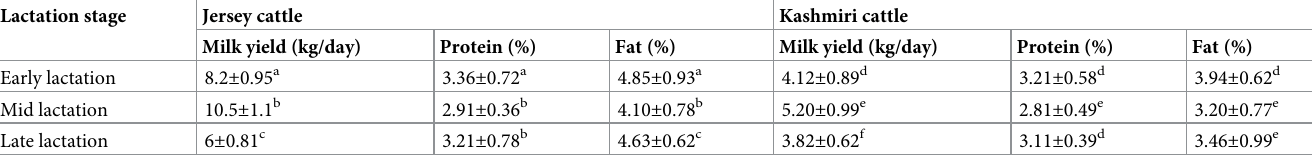
Table 1. Milk yield and component traits 1 in Kashmiri and Jersey cattle at different stages of lactation. Lactation stage Jersey